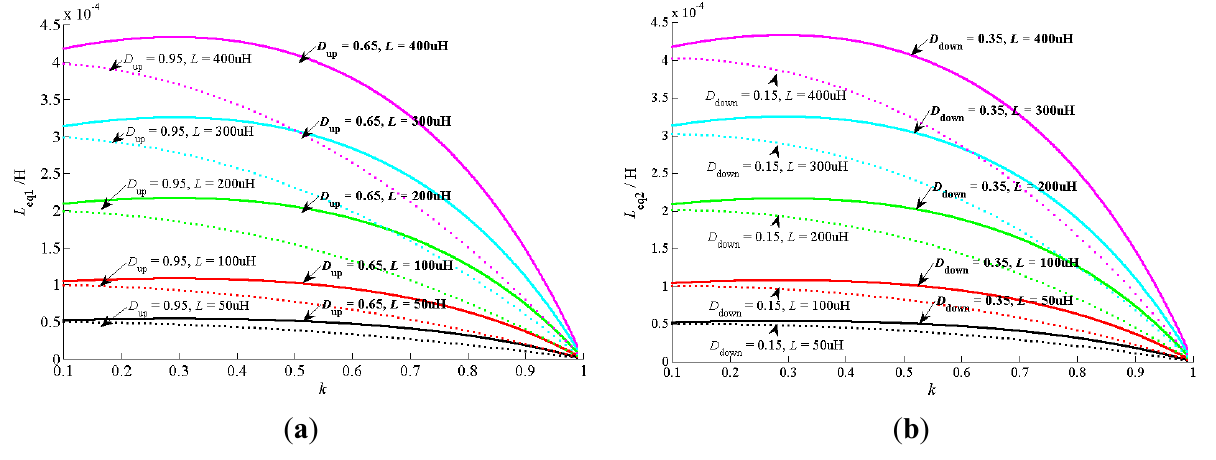
Figure 15. Equivalent inductance curves versus k and D ( a ) CCM Boost; ( b ) CCM